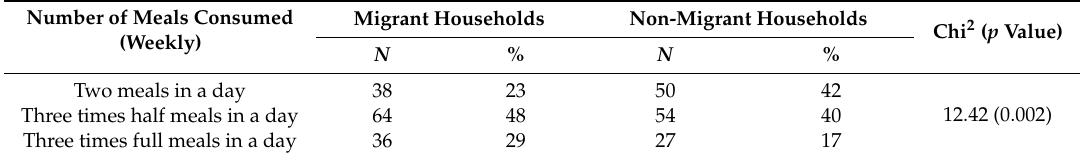
Table 13. Food consumption pattern